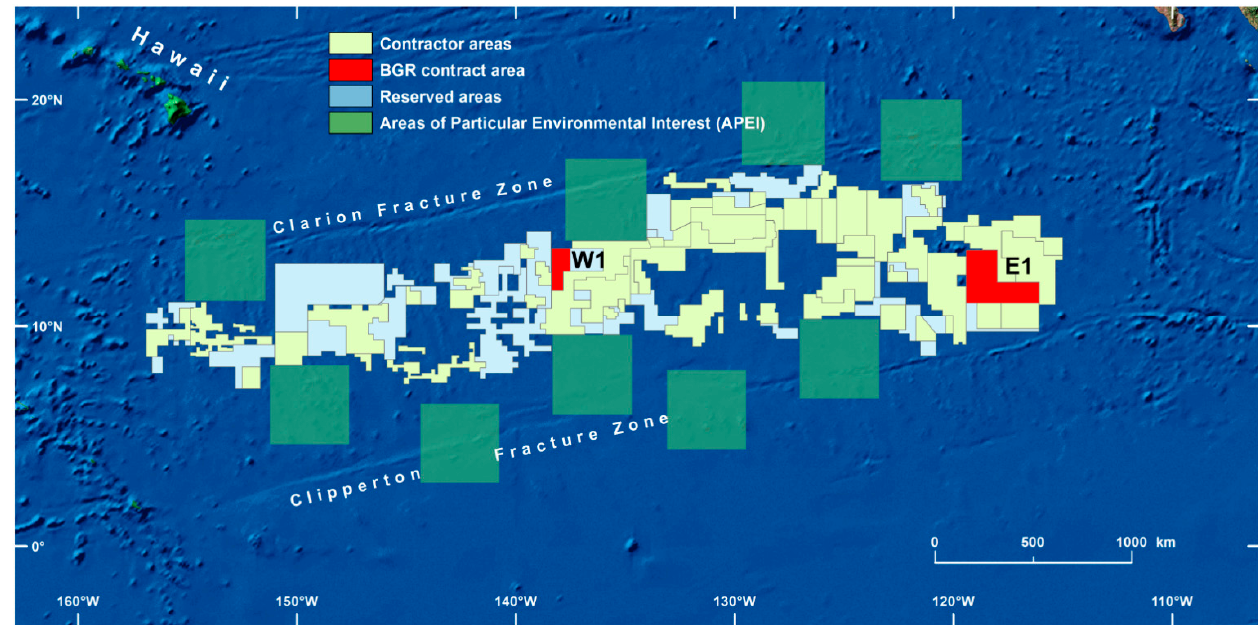
Figure 1. Map of the manganese nodule belt between the Clarion and Clipperton fracture zones in the East Pacific. The two parts W1 and E1 of the German contract area are highlighted in red. The yellow areas are exploration areas of other contractors, blue-grey areas indicate “reserved areas”, for which developing countries can obtain exploration contracts, and the green squares indicate Areas of Particular Environmental Interest (APEI). APEIs form a network of large no-mining zones that are intended to cover the full range of habitats, biodiversity and ecosystem functions [3].